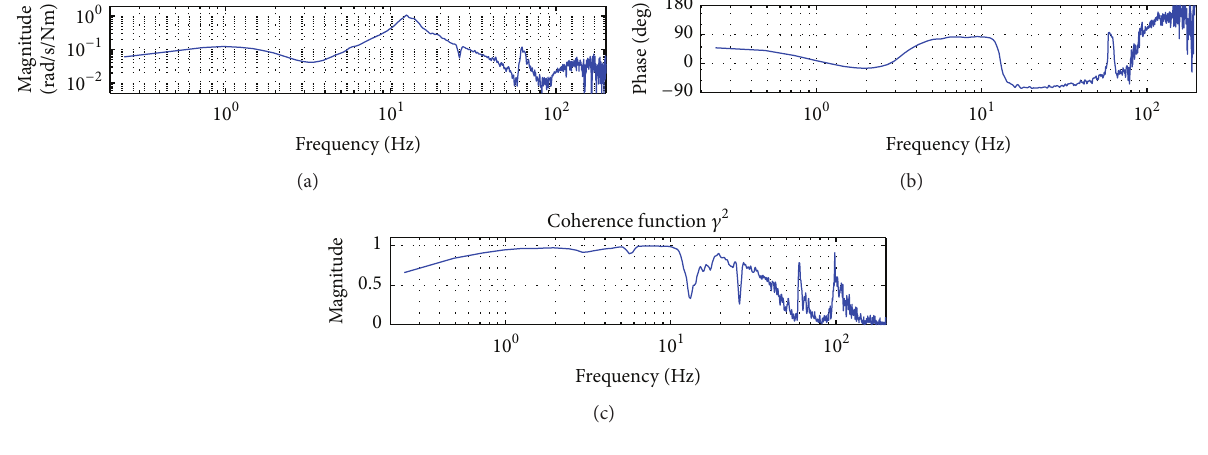
̇𝜃 𝑇 5 / 5 : modulus (a), phase (b), and coherence function (c).